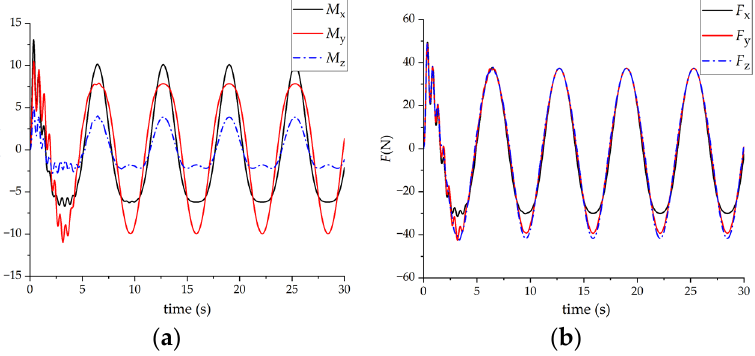
Figure 8. The output of the virtual force sensor: ( a ) torque profiles and ( b ) force profiles.